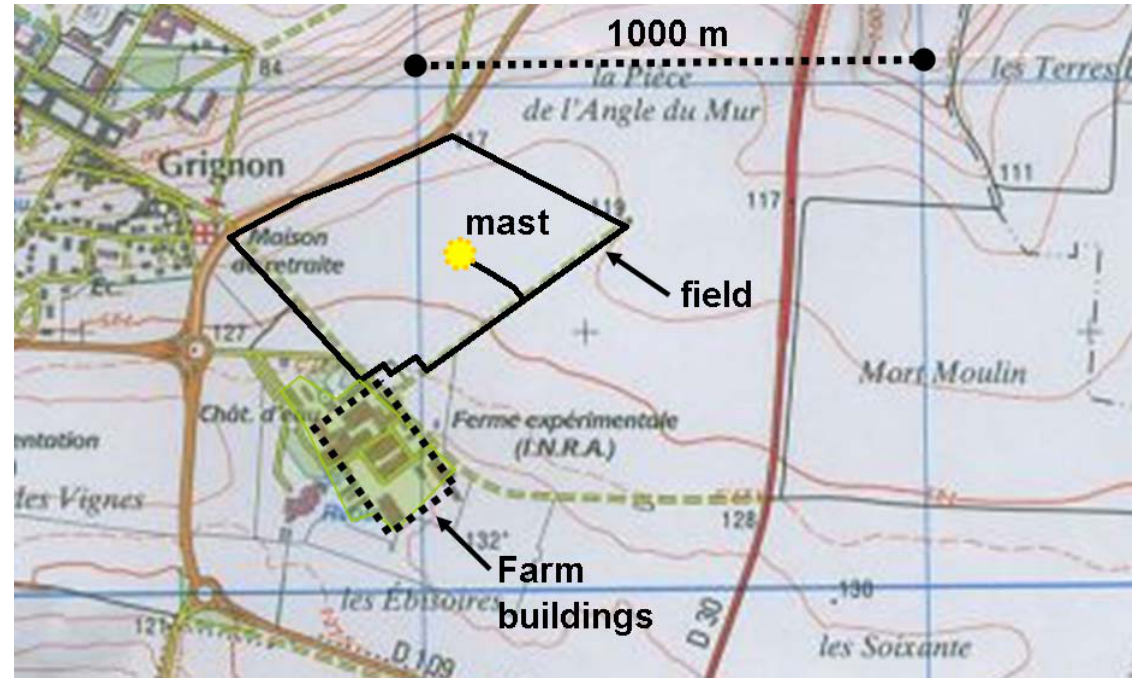
Figure 1. Map of the experimental area showing the field (solid black line), the farm buildings (dotted line) and the mast location (yellow dot). During the experimental campaign the crop grew from 0.5 m to around 0.95 m, and the one sided leaf area index (LAI) changed from 3 to 4 m 2 m − 2 during the